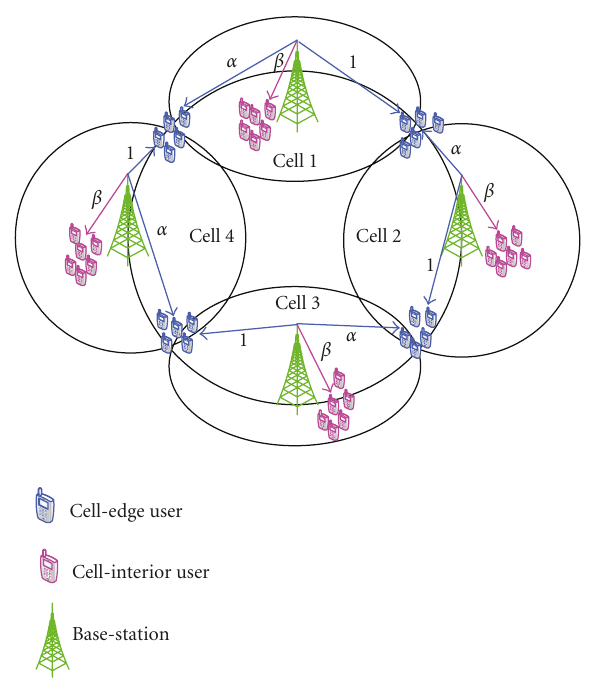
Figure 1: (4,6,5) double-class